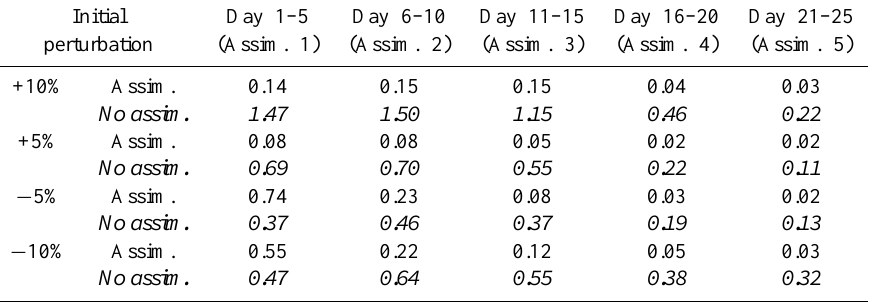
Table 1. Ratio-root mean square error (Ratio-rmse) on discharges (compared to observations), with (straight) or without ( italics ) assimilation consecutive to a perturbation on the ISBA initial soil moisture (on day 1). Four different twin experiments are shown, and the evolution of the assimilation system is given for the first five consecutive assimilations. The state variable is taken as described in Eq.